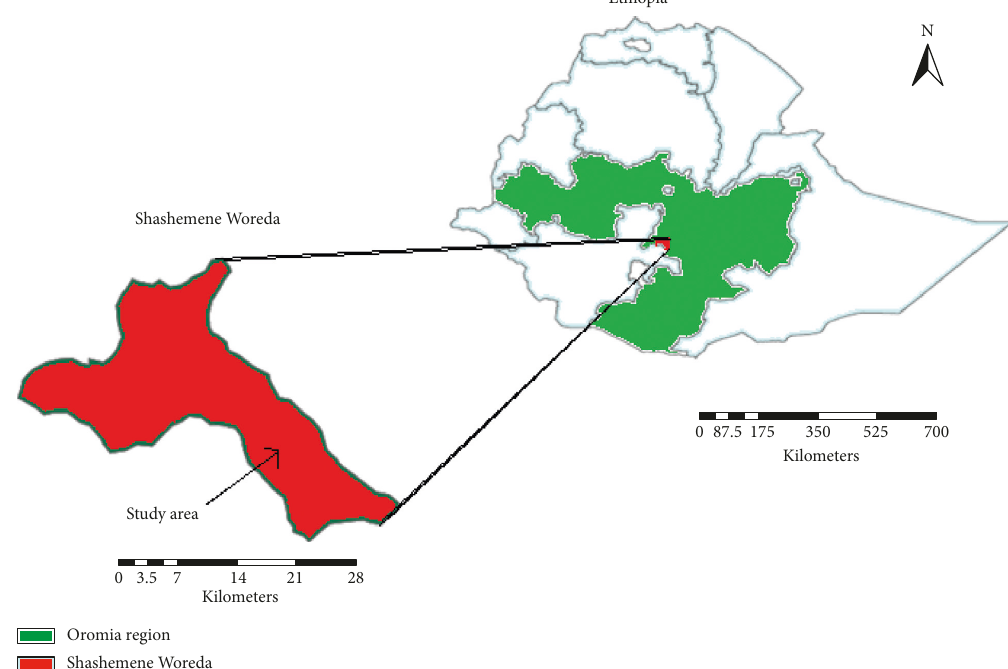
Figure 1: Location map of Shashemene